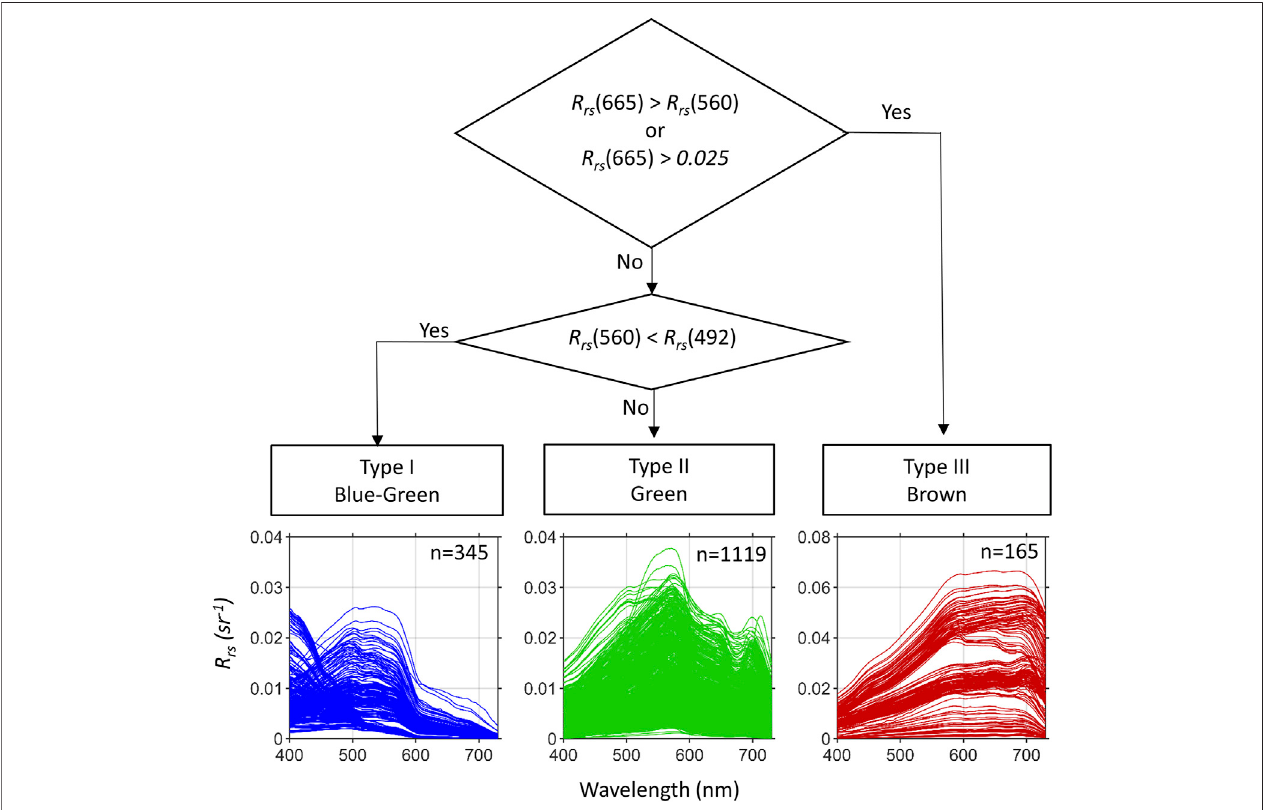
FIGURE2| Asimplescreeningapproachmodi fi edfromBalasubramanianetal.(2020)wasusedtoevaluatetheQWIPapproachforthreewatertypes:Blue-green, Green, and Brown. The remote sensing spectra shown are from the (CASCK-P) training dataset and are identi fi ed with color and shape in Figures 3 , 4 based on this